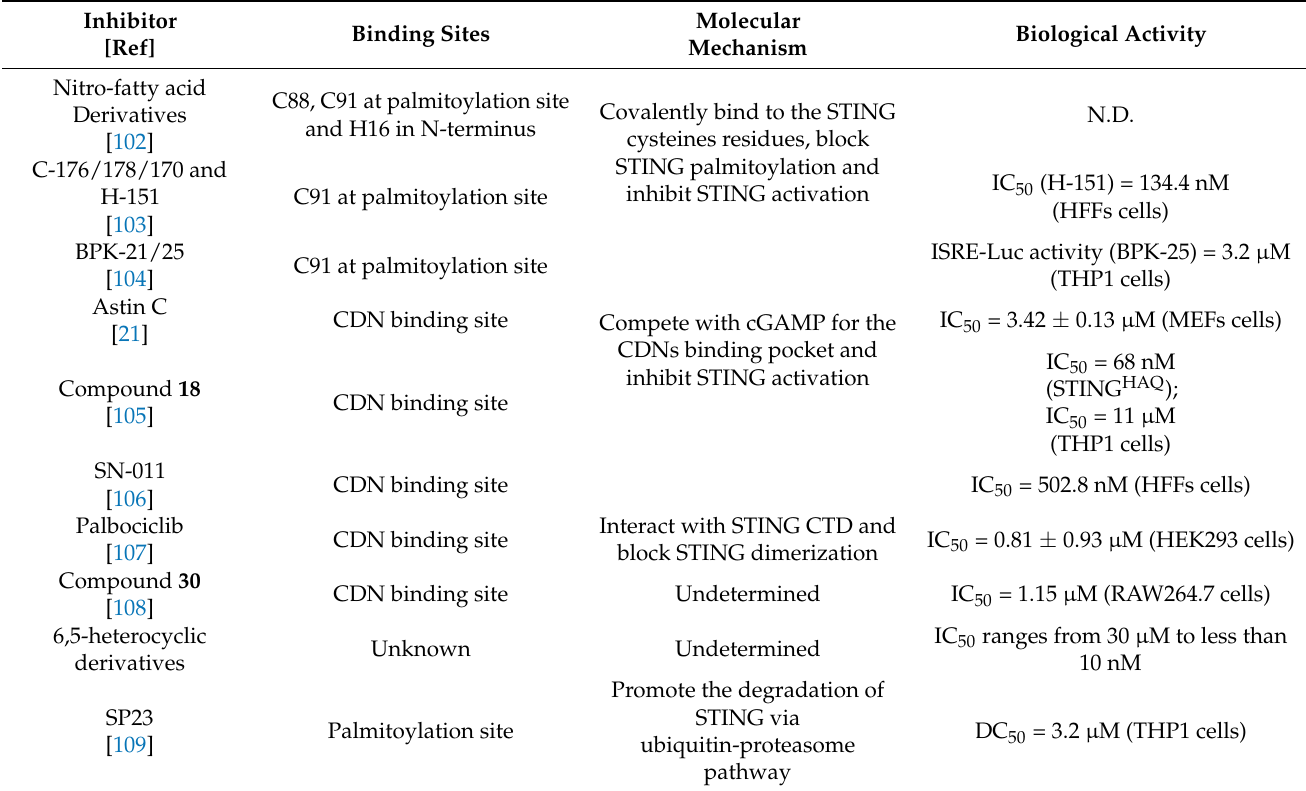
Table 1. An overview of STING